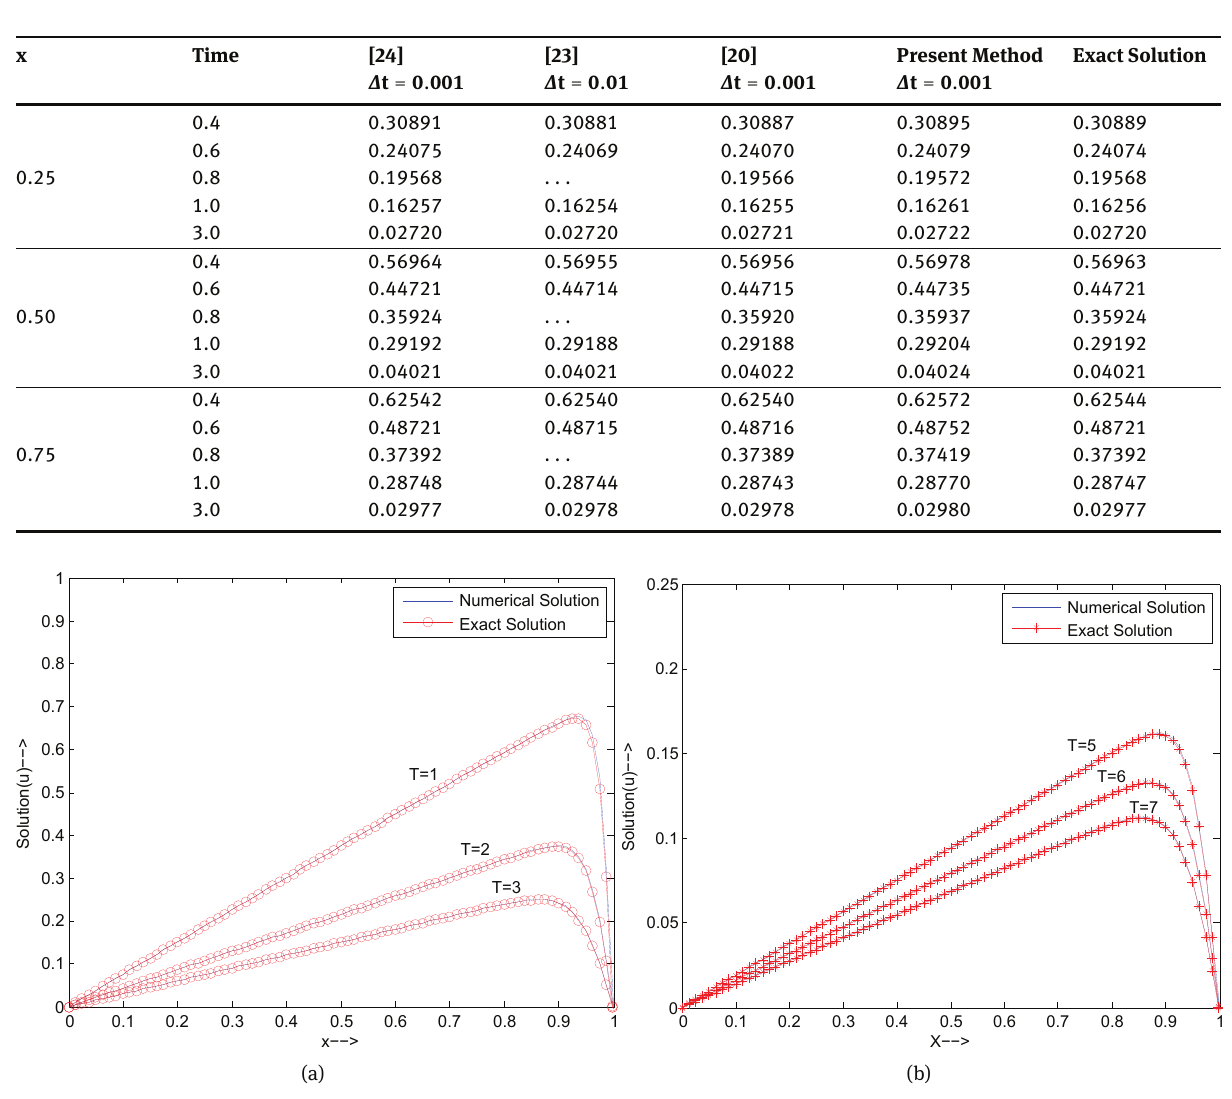
Table 3: Comparison between exact and existing numerical solutions of Example 1 for ν = 0.1 at different times T and x .